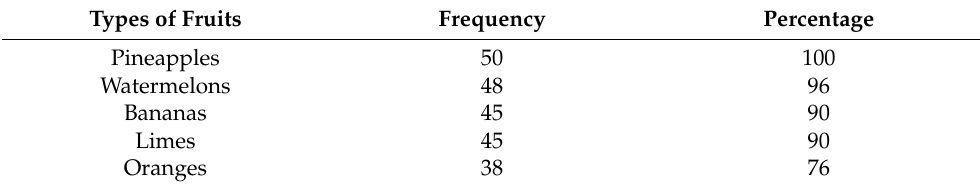
Table 2. Distribution of the fruit species sold by the respondents ( n =